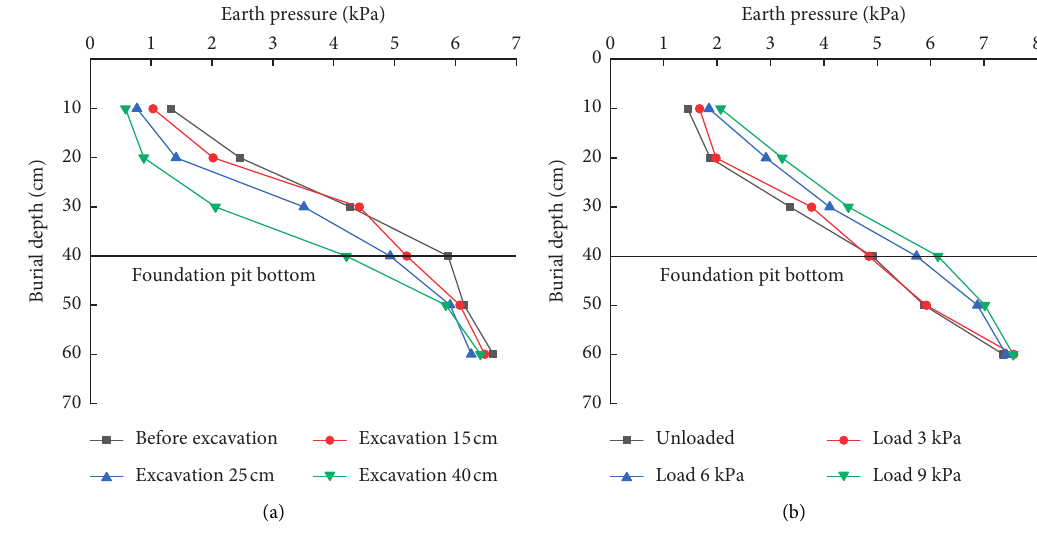
Figure 5: Distribution curves of stress on the back of the piles. (a) Excavation stage. (b) Loading